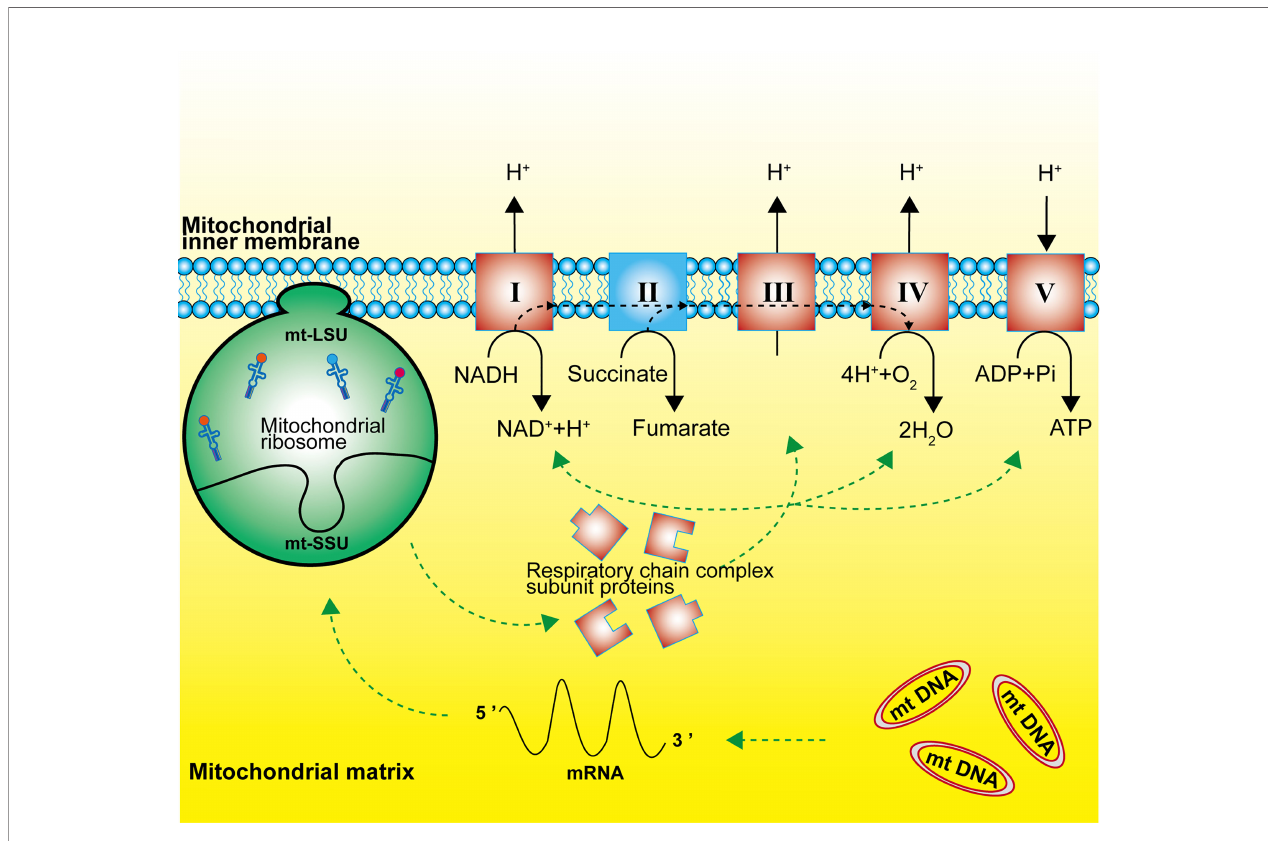
FIGURE 2 | Function of the mitochondrial ribosome. Mitochondrial ribosomes synthesize the subunit proteins of OXPHOS complex I, III, IV and V, which are encoded by the mitochondrial DNA. The dashed black line represents the fl ow of